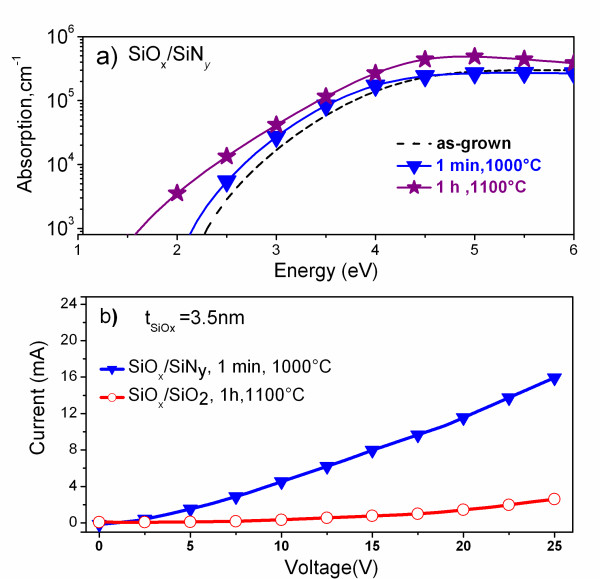
Absorption coefficient and current-voltage behavior. (a) Evolution of absorption coefficient with annealing; (b) Comparison of current-voltage behavior of SiOx/SiNy and SiOx/SiO2 MLs.